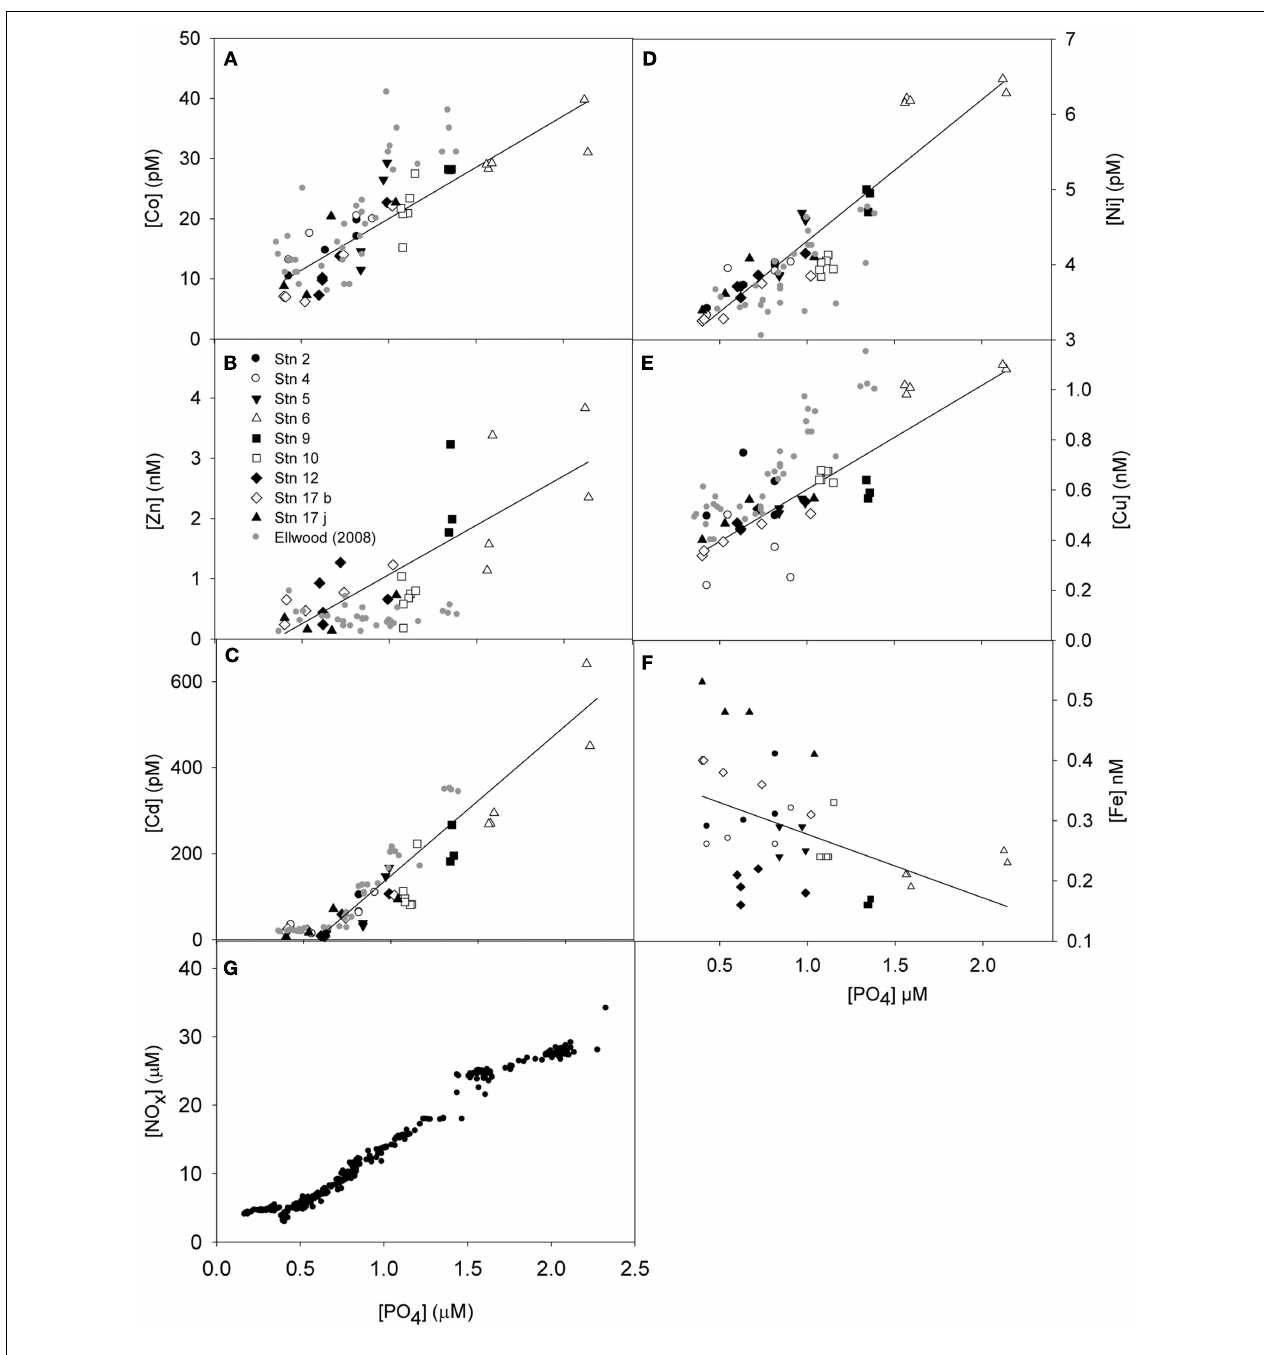
coefficient of correlation for linear regression are shown. Data from a previous study in the region is also shown (Ellwood, 2008). It is to be noted that Ellwood (2008) did not cross the North Polar Front into Antarctic Zone, which could explain some discrepancy. Data for Fe are from Lannuzel et al.